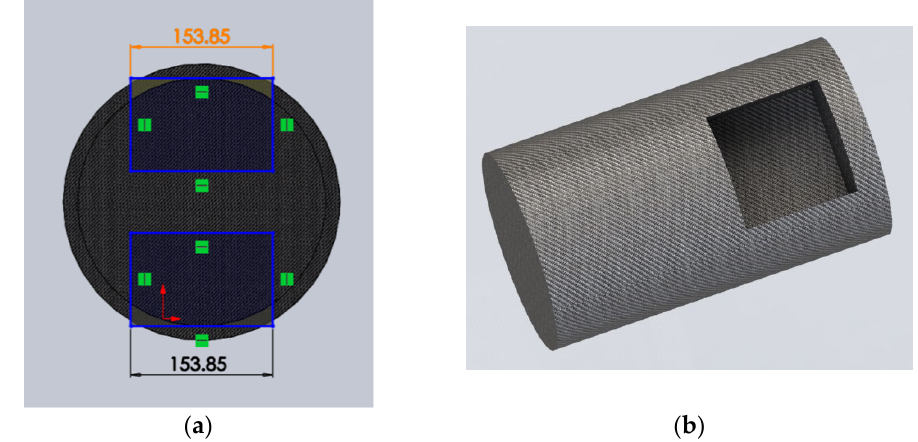
Figure 5. The shaft: ( a ) dimensions for the magnet slots: ( b ) CAD model of the magnet shaft. The casing needed to fit securely against the outside of the downpipe to ensure no water would escape and interfere with the electronics of the electromagnetic induction.